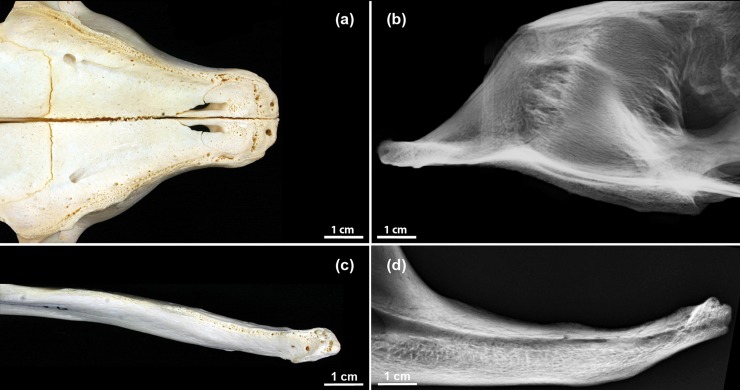
Skull of an anodont 5-year-old male Eastern Atlantic harbor seal (Phoca vitulina vitulina, specimen ZIK 4626).(a) Ventral view of incisive and maxillary bones. (b) Radiograph of anterior skull region (laterolateral projection). (c) Dorsal view of left mandible. (d) Radiograph of left mandible (mediolateral projection). Note that the (tooth-dependent) alveolar structures are also missing.